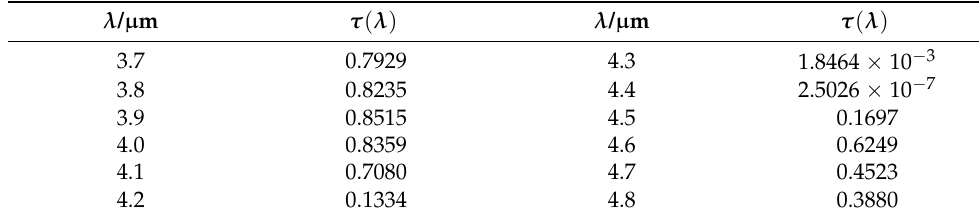
Table 4. Atmospheric transmittance of each